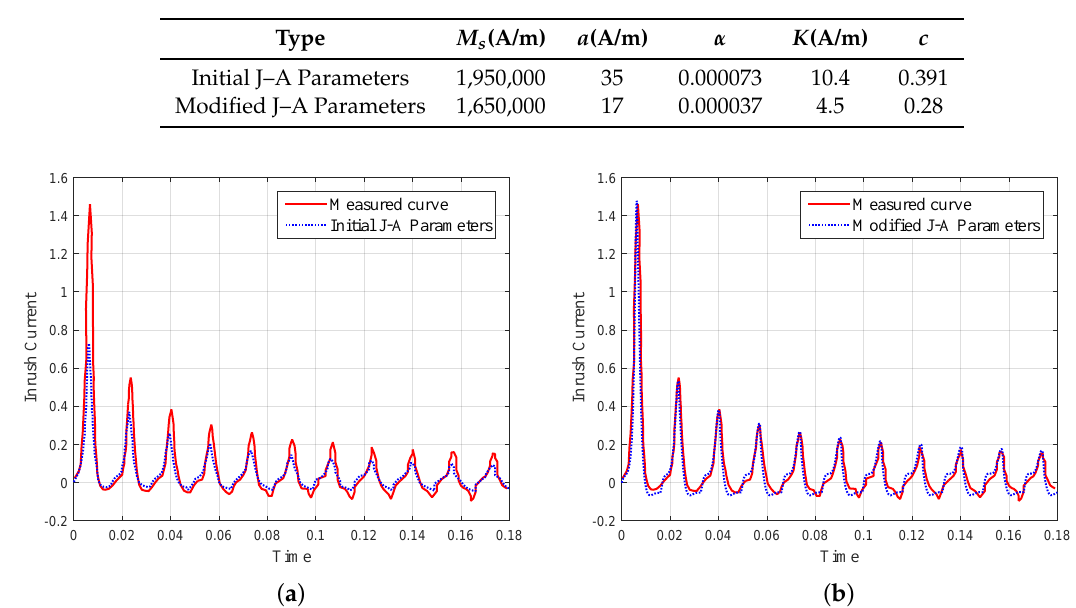
Figure 5. Inrush current comparison between the measured one and the simulated one with ( a ) initial J–A parameters ( b ) modified J–A